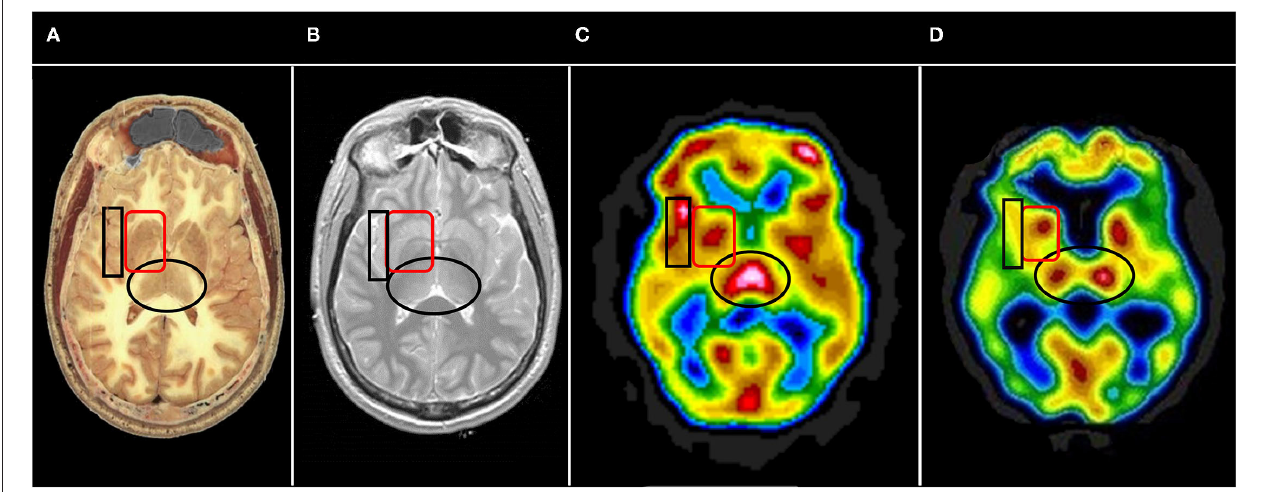
FIGURE 6 | Representative horizontal sections at the level of the thalamus and basal ganglia from (A) human cadaver, (B) MRI, (C) SPECT of healthy individual, and (D) SPECT of individual with advanced Alzheimer’s disease. The thalami are indicated by the black oval in each frame. In healthy individuals the thalami are closely approximated with a narrow 3 rd ventricle separating each side. Note the separation of the thalami in (D) , consistent with volume loss due to degenerative changes. The basal ganglia are indicated by the red rounded square. The insula is indicated by the black box. Note the close approximation of the insular cortex to the lateral aspect of the basal ganglia separated only by the thin external